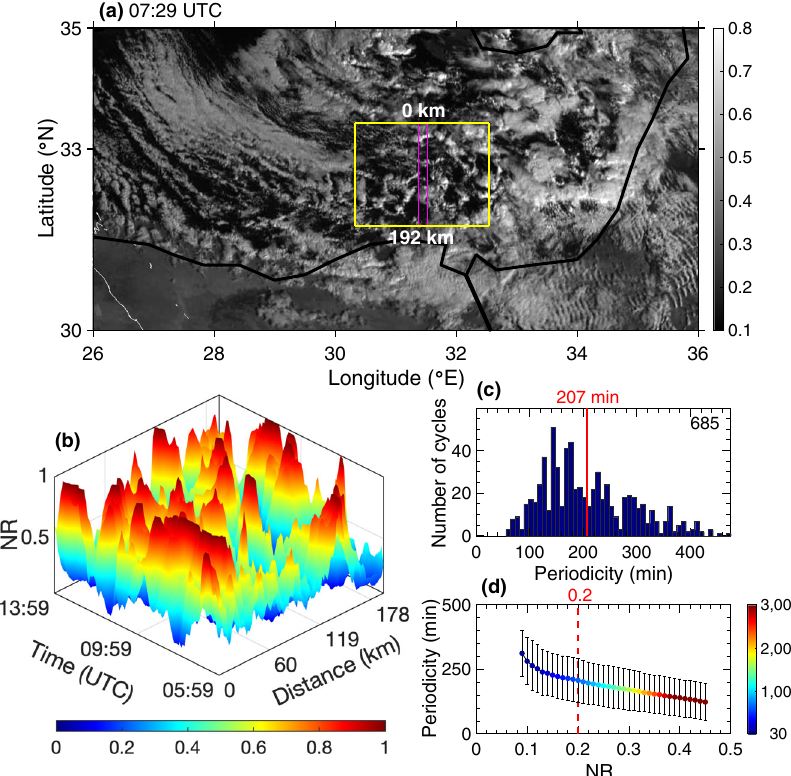
Fig. 2 Evolution of deep-open-cells (26 January 2018). a 07:29 UTC, normalized re fl ectance image (HRV, color bar). The yellow box marks the region of interest (ROI). Black thick lines mark the coast. The scale of distance (in magenta, 0 and 192 km) marks the direction of the x -axis in panel ( b ). b Evolution of the cross-sections ’ normalized re fl ectance (NR, both the Z -axis and the colors), averaged over the central narrow strip (bounded by magenta lines in panel ( a )). c Histogram of estimated periodicity of deep-open-cells over the ROI. The red line indicates the average value (207 min). The black number at the top right indicates the total number of samples (685). d Average periodicity for deep-open- cells as a function of the critical normalized re fl ectance (NR c ) (from 0.05 to 0.45, in 0.01 intervals). The colors denote the number of samples, the error bars represent ±1 standard deviation, and the dashed red line marks the NR c = 0.2, used in panel ( c the inversion base height, and hence indicates the cloud top height (Fig. 3c, used for comparison with modeling results). A low- level inversion is observed on the west side of the cross-section (at ~800 hPa; 2 km), with a subsidence of dry air above it, while the east side shows a much deeper convective boundary layer, reaching up to ~500 hPa (5.5 km). The analysis shows that the observed cloud streets were formed within a relatively shallow convective layer, while the open cells developed in a much deeper convective layer. Figure 1c shows a histogram of equivalent diameters (obtained by converting each cell ’ s area into the surface area of an equivalent circle) of the deep-open-cells observed in the HRV images, at 1-h intervals (to minimize cells ’ re-sampling), between 05:59 and 13:59 UTC. In total, 435 open cells with an average equivalent diameter of ~59 ± 19 km were detected. The cell sizes are in good agreement with previous studies, in which the sizes of open cells during Cyprus lows ranged between 40 and 80 km 22 . The sensitivity of the mean size to the corresponding sampling time (1 h for Fig. 1c) was tested in Fig. 1d. Note that in order to ensure meaningful statistics, only bins with at least 30 samples were analyzed 32 . Similar average diameters for various sampling times suggest low sensitivity and robust results. To explore the evolution of deep-open-cells, we selected a small region of interest (ROI; yellow box in Fig. 2a). A Lagrangian tracking analysis was performed (see Methods section for details). Normalized re fl ectance (NR, colors) values were averaged between 05:59 UTC and 13:59 UTC (Fig. 2b), over the central narrow strip (~15 km in width and ~192 km in length, marked by the magenta